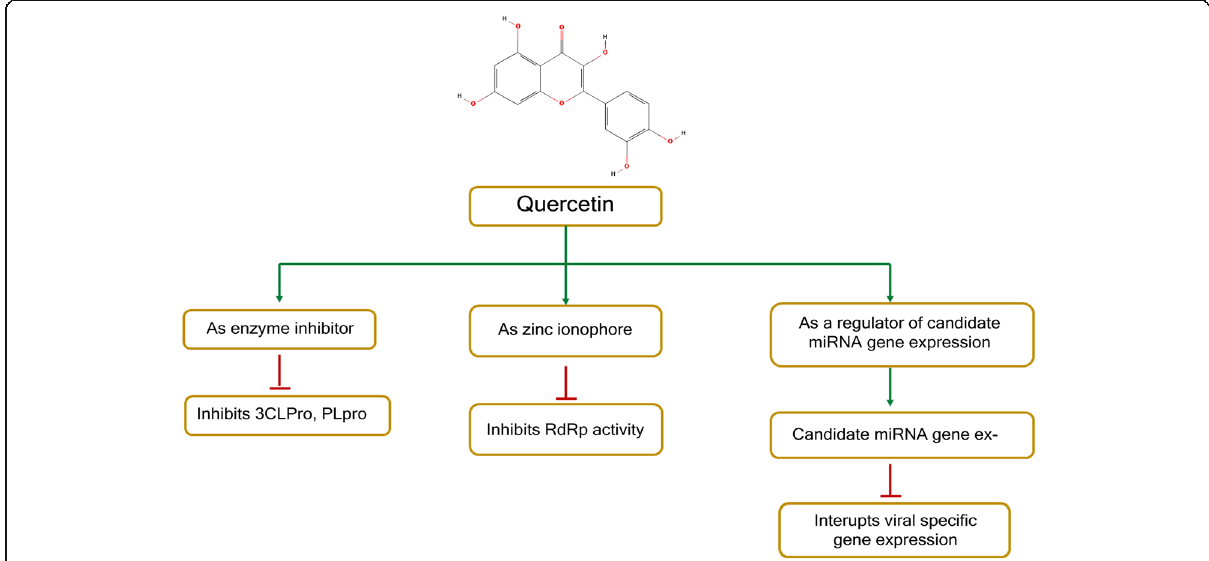
Fig. 1 Multiple paths through which quercetin effects its antiviral